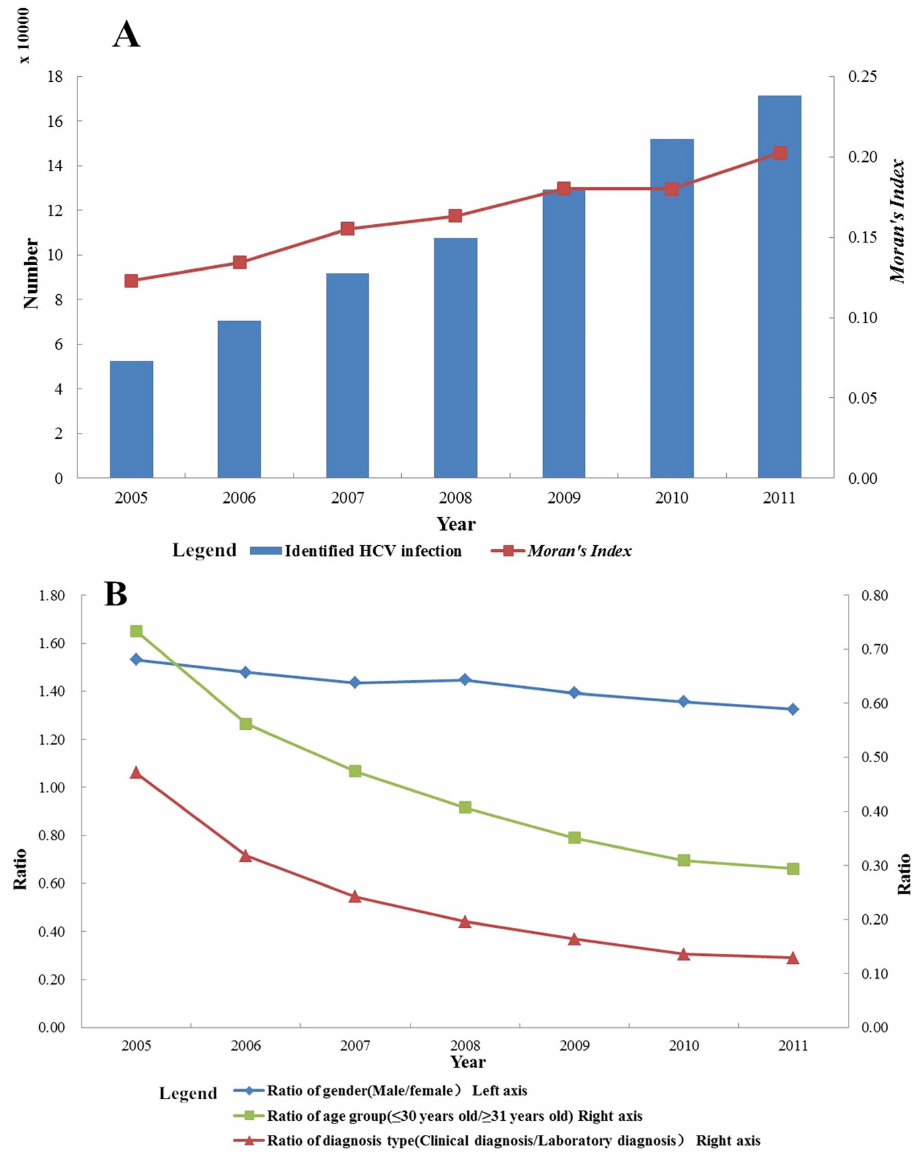
Figure 1. (A) Number and Moran ’ s Index of identified HCV infection cases by year. (B) Ratio of gender, age group and diagnosis type of identified HCV infection cases by year.